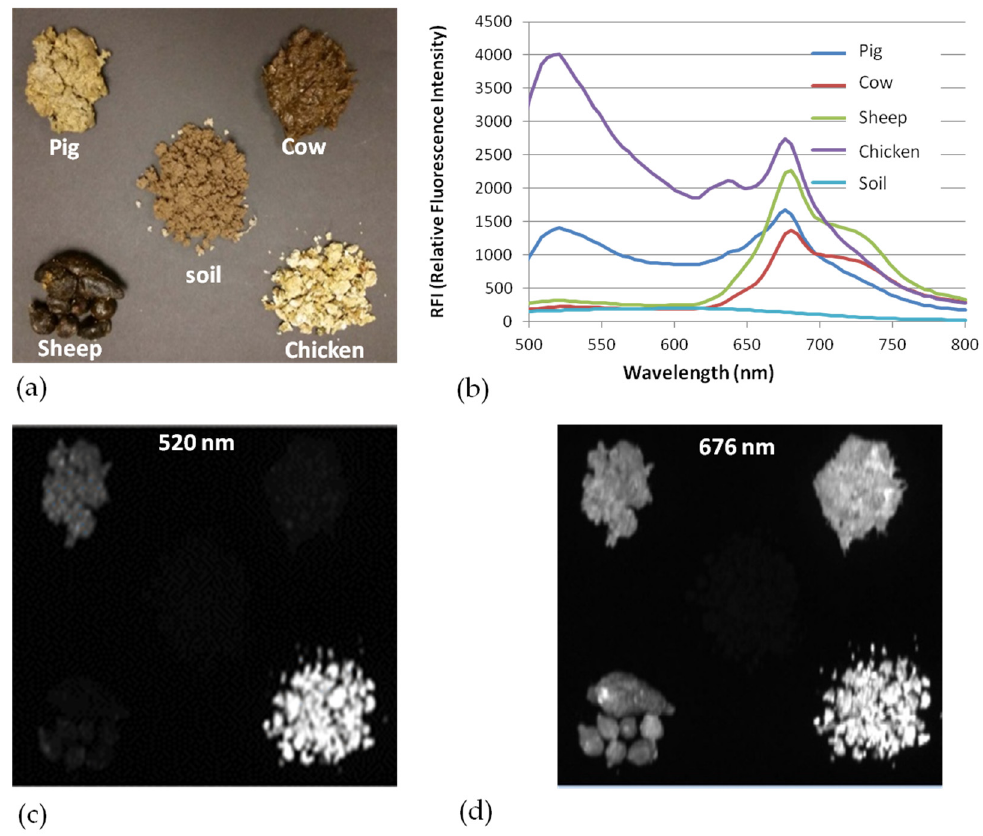
Figure 2. ( a ) Color photo of feces samples from four animal species and one soil sample; ( b ) Representative fluorescence spectra of animal fecal and soil samples. Hyperspectral fluorescence images of the samples acquired at ( c ) 520 nm and ( d ) 676